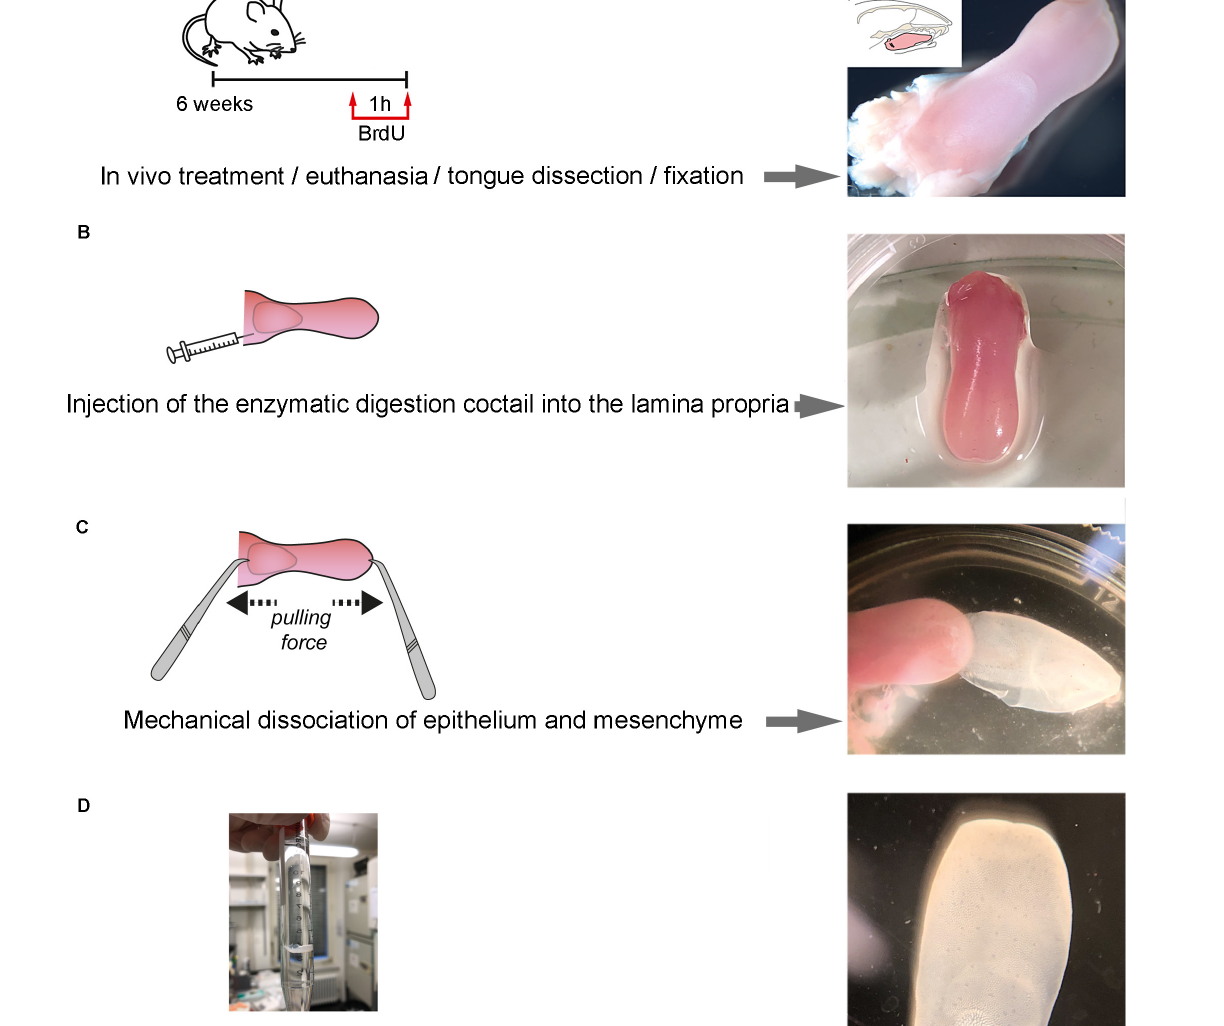
12. Transfer the tongue into a petri dish under the